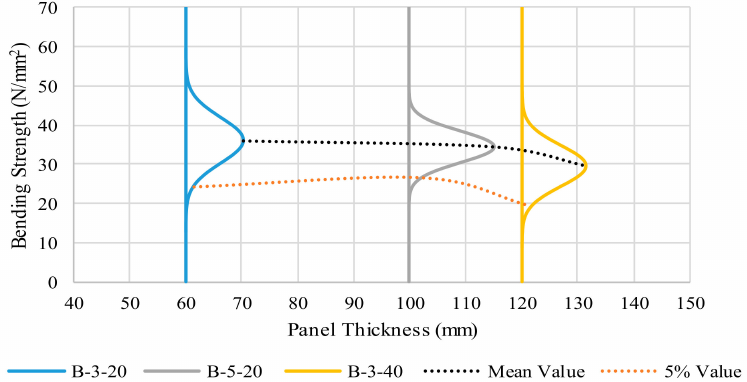
Figure 7. Bending strength distribution and influence of panel thickness and number of layers.